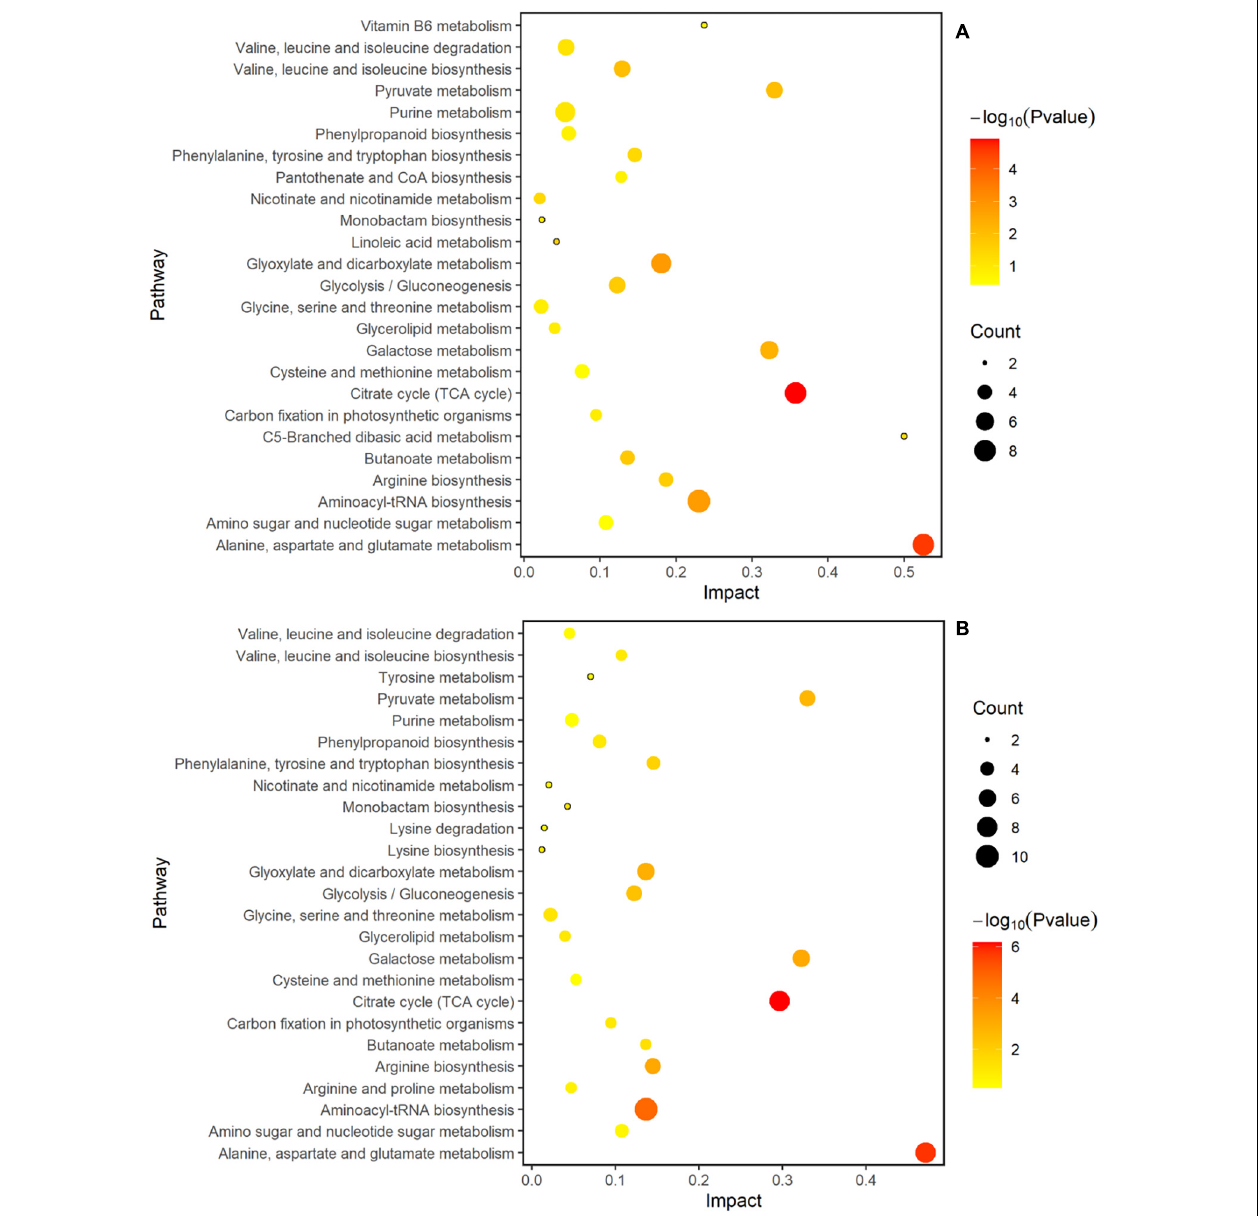
FIGURE 11 | Analysis of metabolic pathways of TLP-DN6 and TS-DN6. Results were from the analyses using the MetaboAnalyst 4.0 software. Every circle represents a metabolic pathway, with red color indicating higher impact and yellow color indicating lower impact. The pathways with p -value < 0.05 were determined to have significant changes. The size of the circle represents the number of DEMs participating in the pathway. (A) Rice samples of DN6 at the TLP, (B) rice samples of DN6 at the TS.